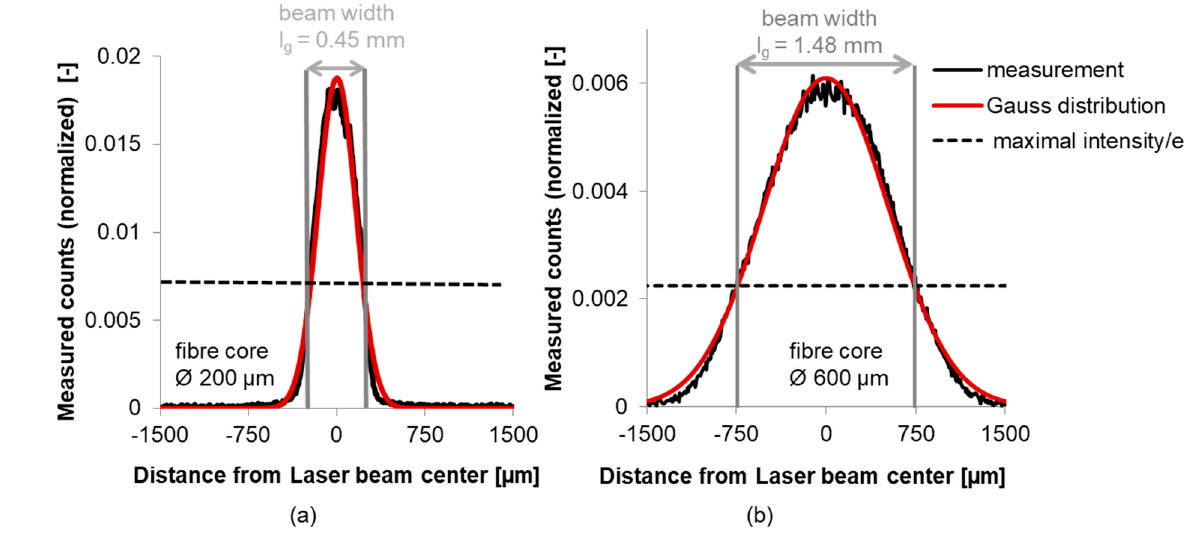
Figure 7. Measured and modeled intensity distribution of laser beams generated by fiber core diameter of 200 ( a ) and 600 µm ( b ).